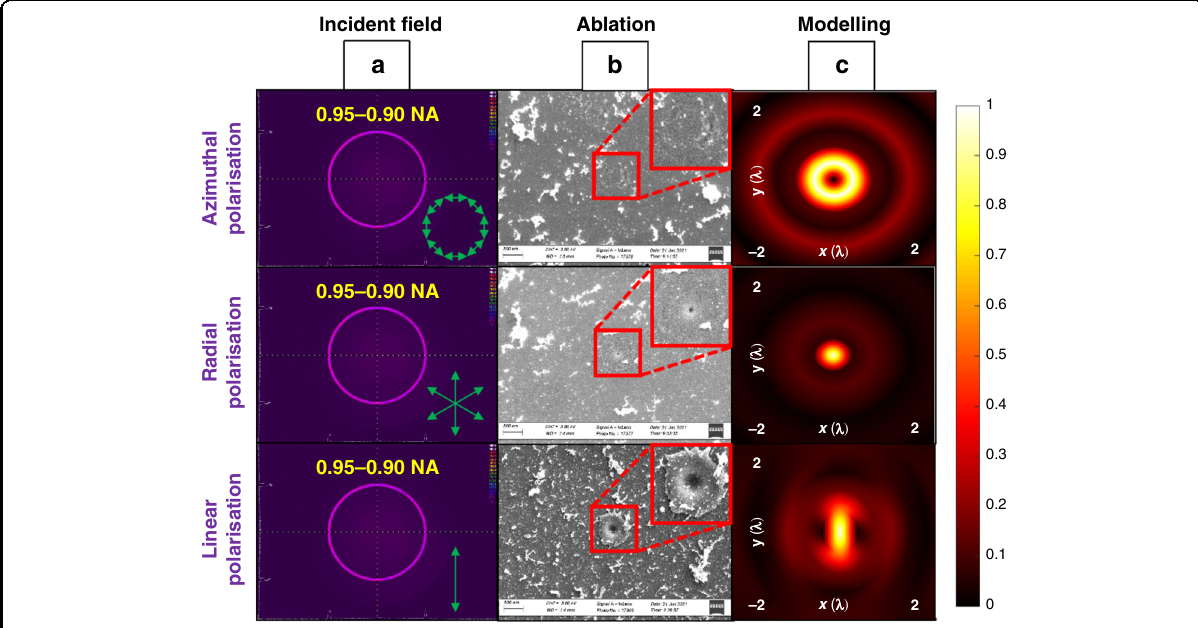
Fig. 4 Comparison of effect of annular beam with different polarisation states on laser ablation on sapphire. a The intensity distribution of 0.95 – 0.90 NA annular Gaussian beam, b focused laser ablation with single pulses on polished sapphire (insets show ×2 magni fi ed views, with increased contrast), c the normalised focal intensity distribution (modelling of the beam intensity cross-section) with azimuthal, radial, and linear polarisation (top to bottom